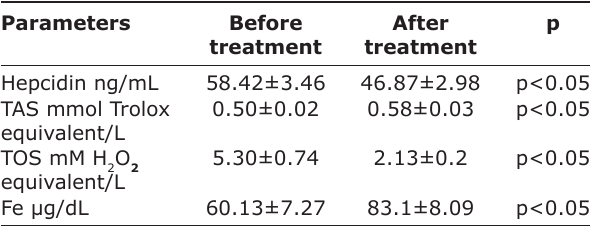
Table-1: Serum biochemical changes before and after treatment (n=15).